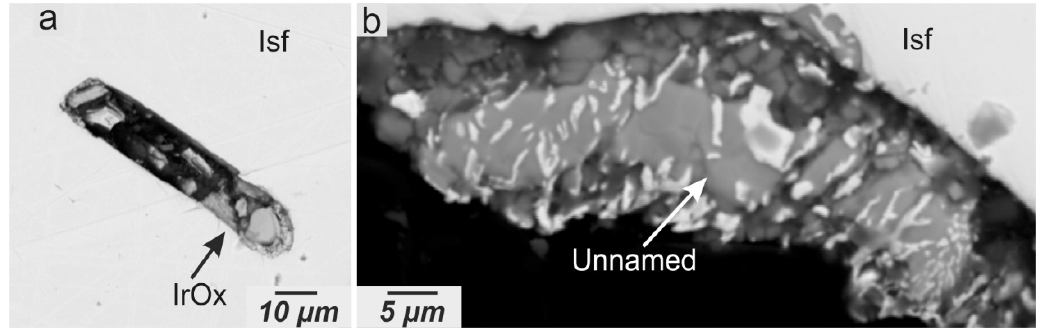
Figure 15. ( a ) the iridium oxide (IrOx) and ( b ) unnamed phase from the Travyanistyi proximal placer. Isf—isoferroplatinum. BSE images (SEM).